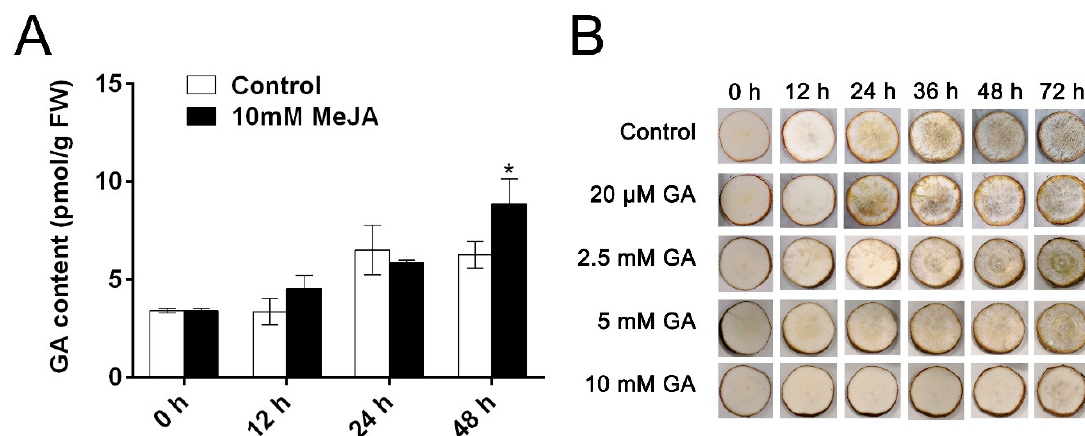
Figure 5. The effects of MeJA on the endogenous gibberellin (GA) levels in stored cassava slices. ( A ) The endogenous levels of GA in cassava storage root slices without and with MeJA pre-treatment. ( B ) Visual detection of storage root slices affected by GA pre-treatment. Data are means ± SD calculated from three biological replicate samples. Asterisk symbols (*) indicate significant differences according to Duncan’s multiple range test at p < 0.05 at the same time.